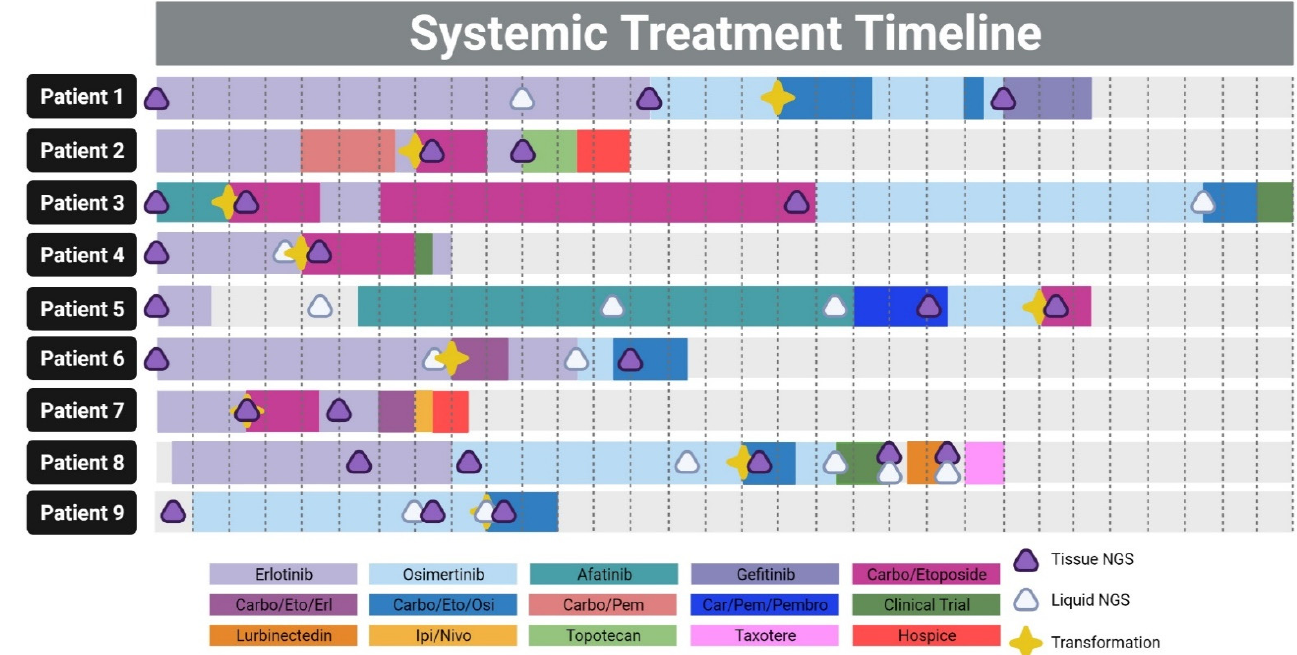
Figure 3. Systemic treatment timeline, the incidence of transformation, and next-generation sequencing time points. The complete history of lines of therapies given for each patient, including the time to transformation, and next-generational sequencing time points, with each box delineating two months. Created with BioRender.com.